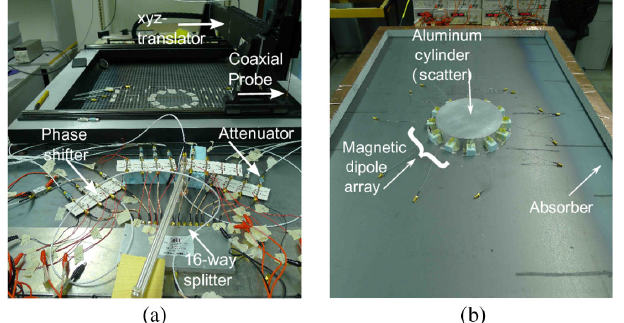
FIG. 6. (a) The exterior of the waveguide setup. Pictured are the phase shifter, translator, and coaxial probe. The VNA is just outside of the picture and to the left. (b) The interior of the waveguide setup. The loop antennas conformally surround the